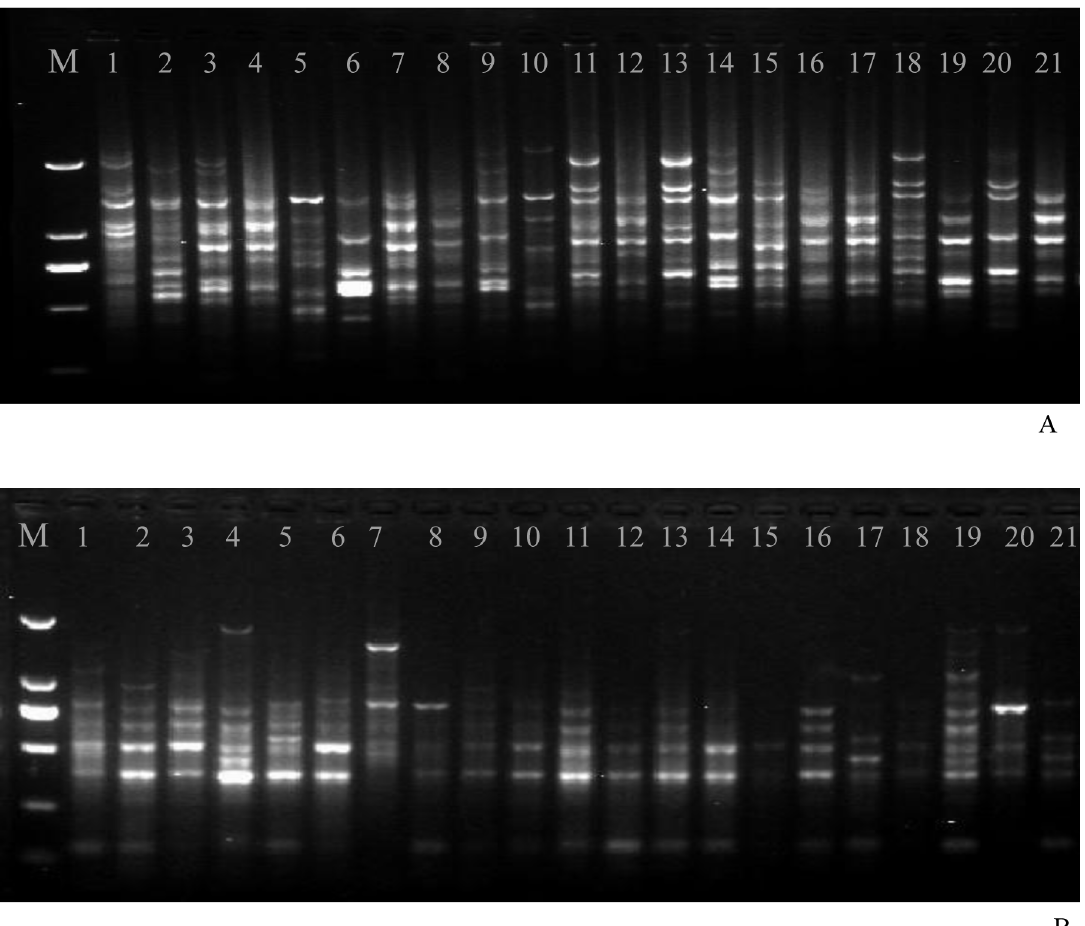
Fig 3. Representative molecular marker profile. (A): ISSR profiles in the tested 21 strains of Blumeria graminis f. sp. tritici with primer 807. (B): SRAP profiles in the tested 21 strains of Blumeria graminis f. sp. tritici with primer Me2/Em8.